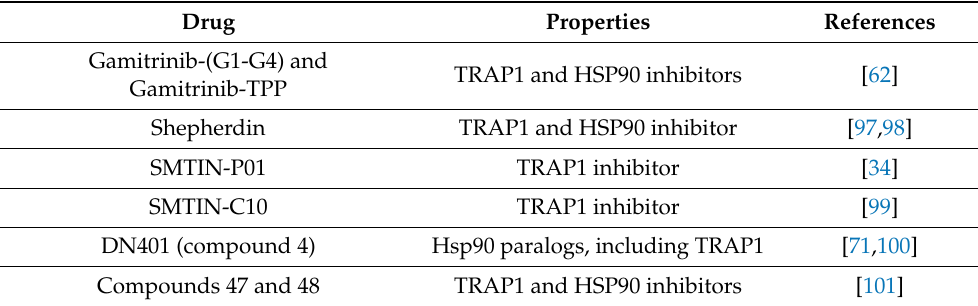
Table 1. List of TRAP1